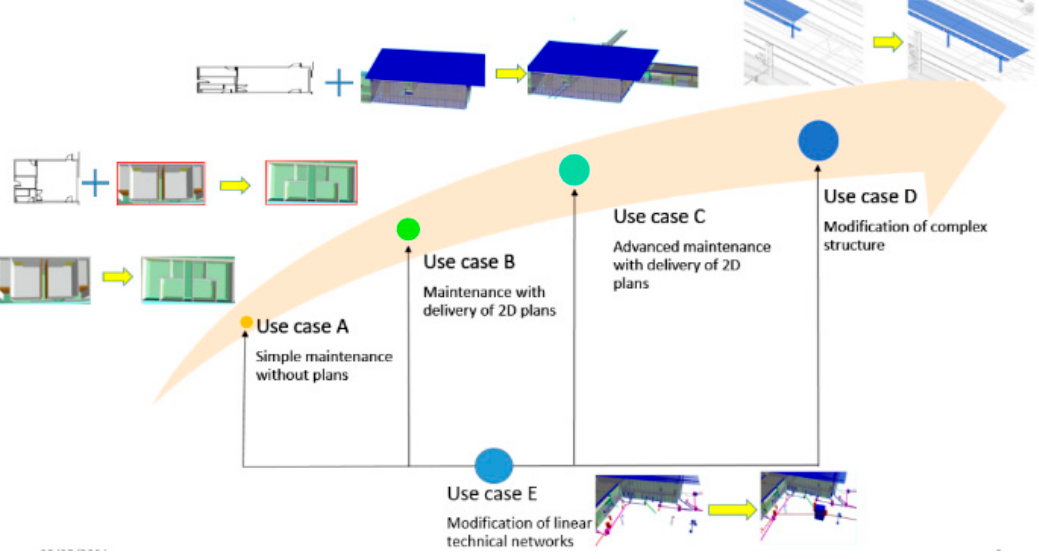
Figure 2. Different use cases of the experimentation presented in several situations of maintenance